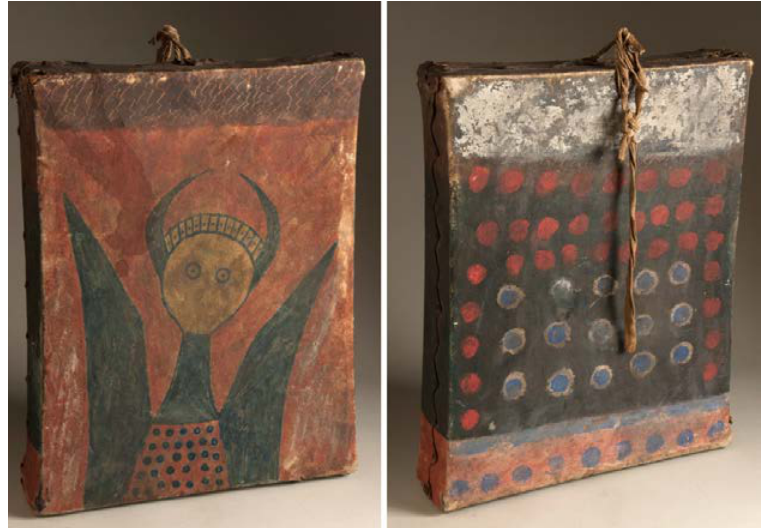
Figure 4. Hand Drum (front and back) Attributed to Siyosapa (Hunkpapa/Yanktonai). Unknown collection date. Wood, rawhide, paint, 44.5 cm × 33.0 cm × 5.7 cm. Used by permission of The Trout Gallery, Dickinson College (1973.1.12).